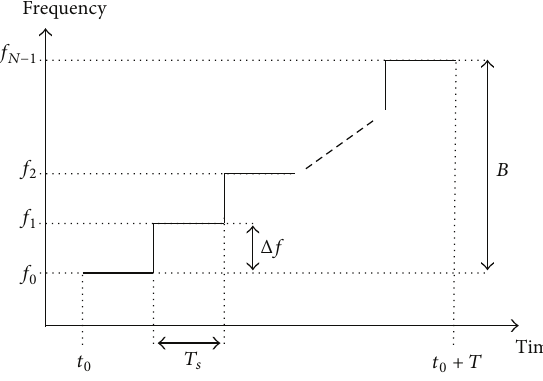
Figure 4: Waveform generation scheme of an SF sensor.